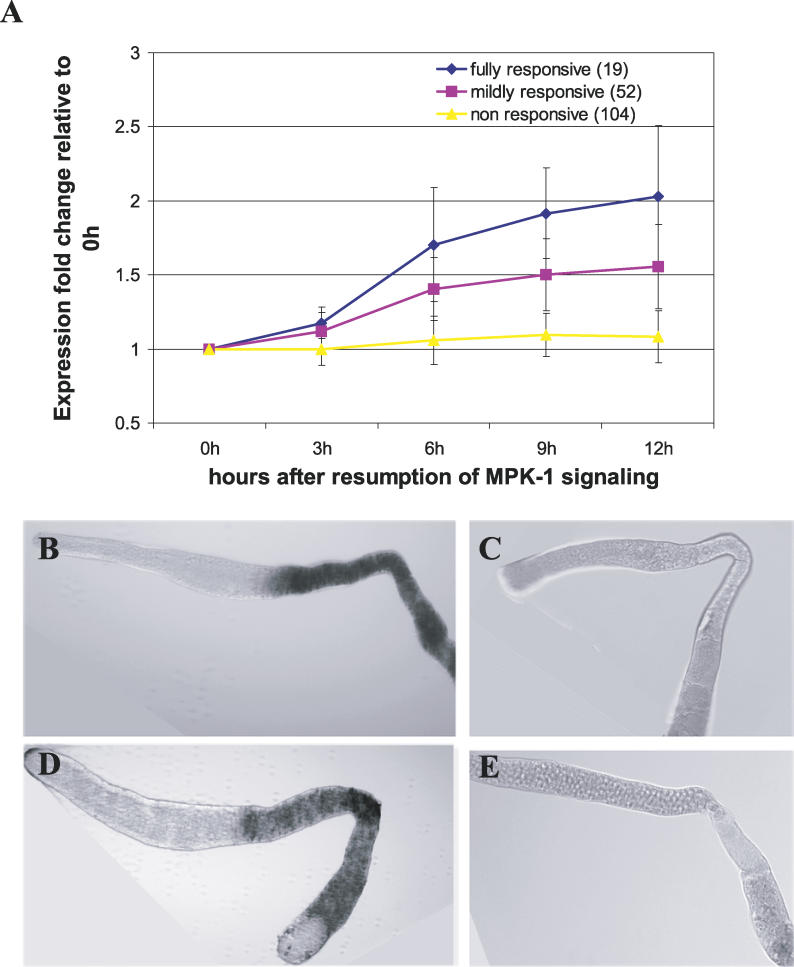
X-Linked Genes Depend on MPK-1 for Germ Line Expression(A) Graph of mean changes in gene expression for X-linked genes in response to MPK-1 signaling. Blue indicates 19 MPK-1 signaling-responsive genes; pink indicates 52 additional X-linked genes with a mild response; and yellow indicates 104 X-linked genes with no response. Error bars indicate standard deviation.(B–E) In situ hybridization of N2 (A and C) and mpk-1 (B and D) gonads with probes for an X-linked MPK-1 signaling-responsive gene, F35C8.7 (A and B), and an X-linked non-responsive gene, C04A11.3 (C and D). Sense probes showed no signal.